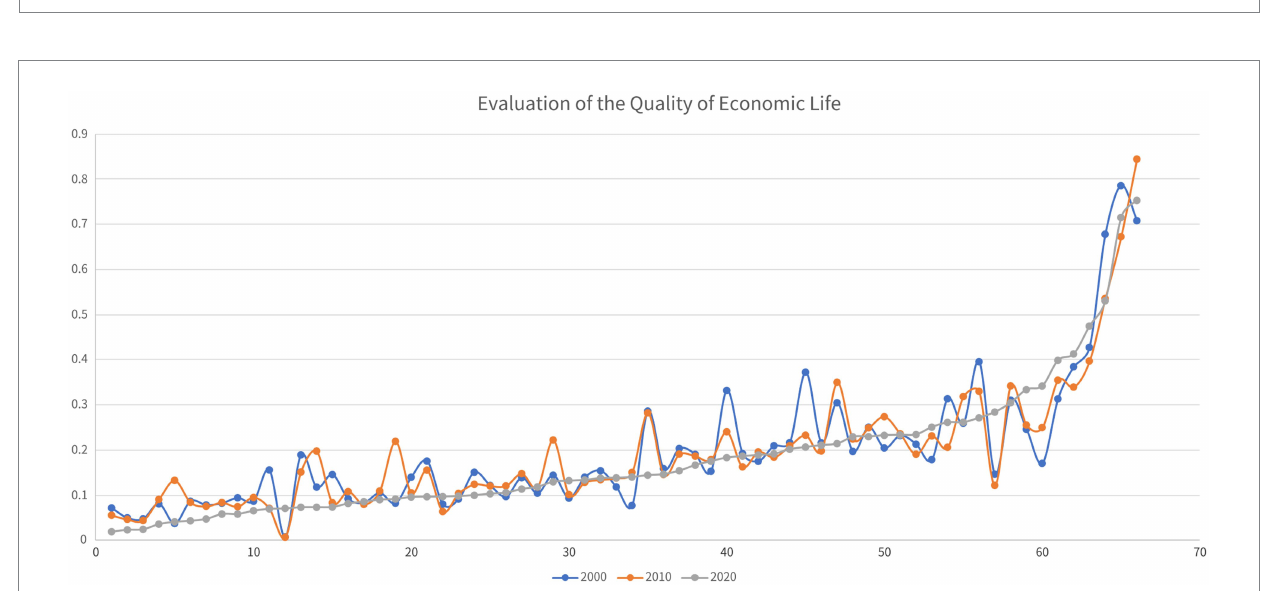
FIGURE 3 Analysis of the evolution of the economic QoL of Guizhou’s districts and counties from 2000 to